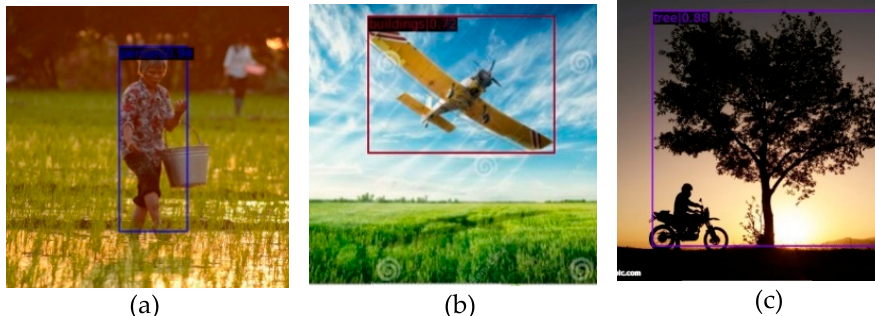
Figure 9. The wrongly detected objects: ( a ) Our model failed to detect the person behind. ( b ) An airplane is mistakenly identified as a building. ( c ) Our model failed to detect a motorcyclist.